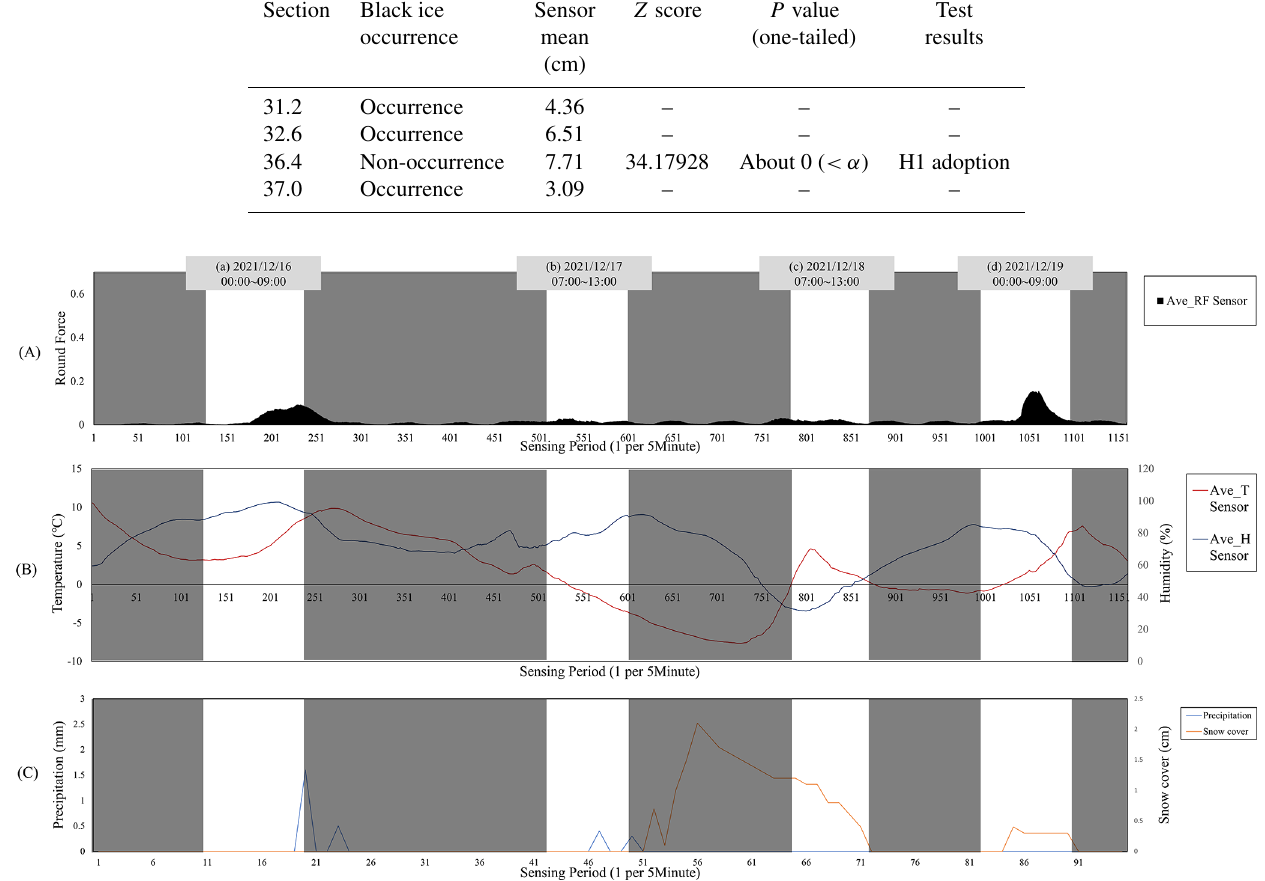
Figure 13. Data analysis result of temperature/humidity sensor. Round force, temperature/humidity, precipitation, and snow cover were